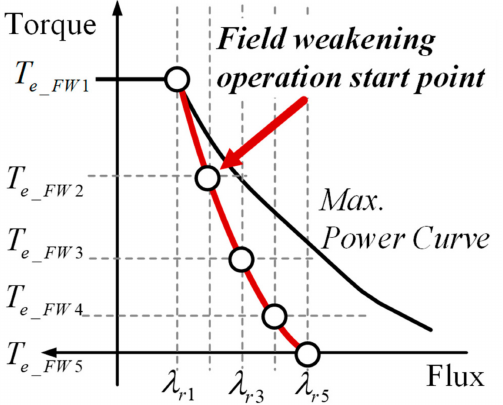
Figure 6. Field weakening operation start points for each